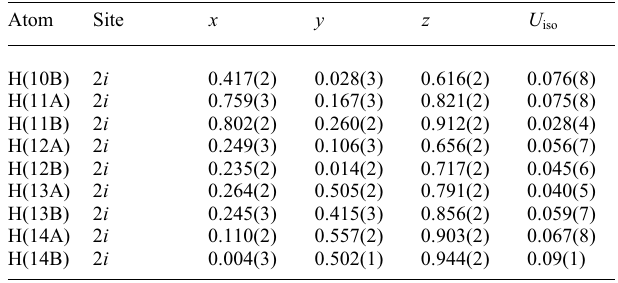
Table 3. Atomic coordinates and displacement parameters (in Å 2